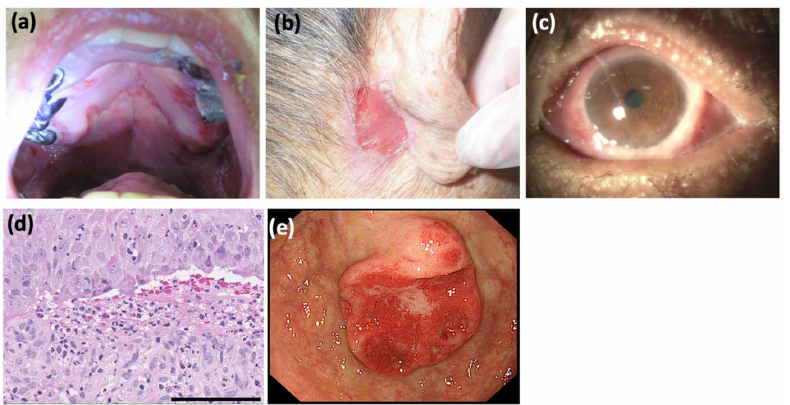
Figure 1. Clinical and histopathological findings. ( a ) The hard palate presented with erosion and ulcers. Erosions and ulcers were also present on the gingivae, the floor of the mouth, and from the pharynx to the esophagus. ( b ) An approximately 25 × 15 mm refractory erosive lesion observed on the retroauricular regions. ( c ) Pseudomembranous conjunctivitis and hyperemic conjunctiva. The upper eyelid adhered to the conjunctiva bulbi and could not be inverted. ( d ) Histopathology for the skin biopsy from left forearm showed subepidermal vesiculation and cleft formation at the dermo-epidermal junction. In the uppermost dermis, there was an inflammatory cell infiltrate mainly of neutrophils with a few lymphocytes and eosinophils (hematoxylin-eosin staining; scale bar = 100 µ m). ( e ) Gastroscopy detected a gastric cancer, 35 × 24 mm in size, which was histologically a well-differentiated